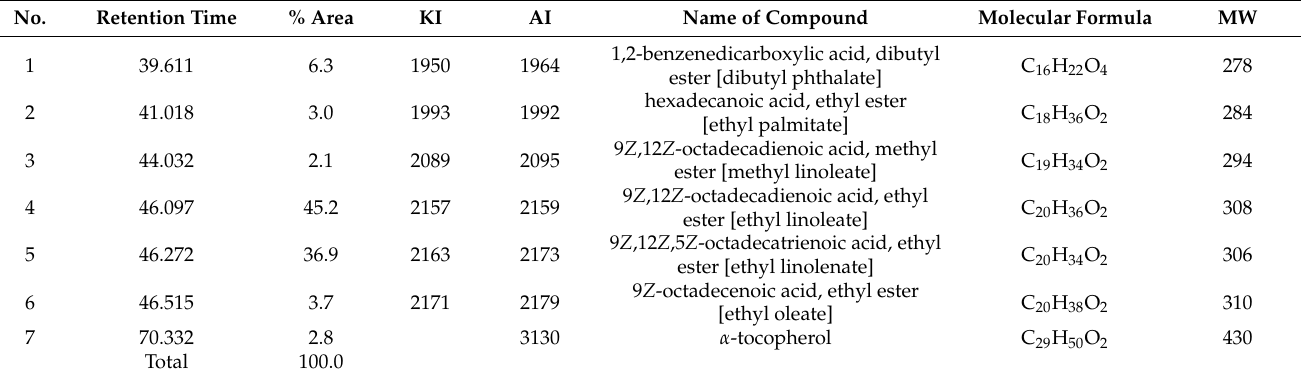
Table 1. Chemical composition of diethyl ether extract of Dioscorea communis berry juice